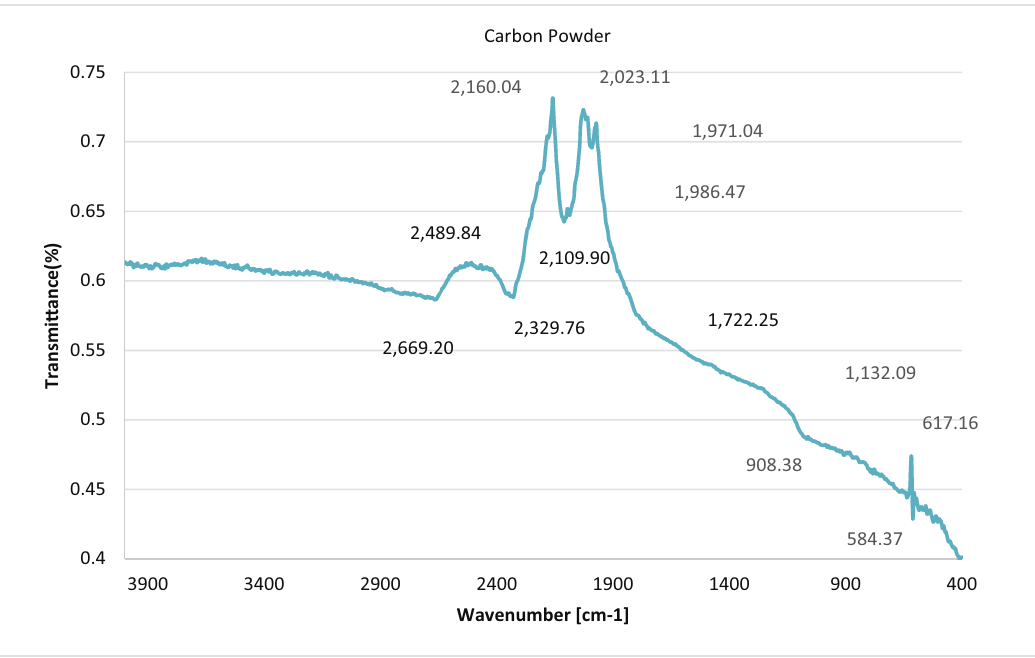
Figure 8: FT - IR results of carbon black